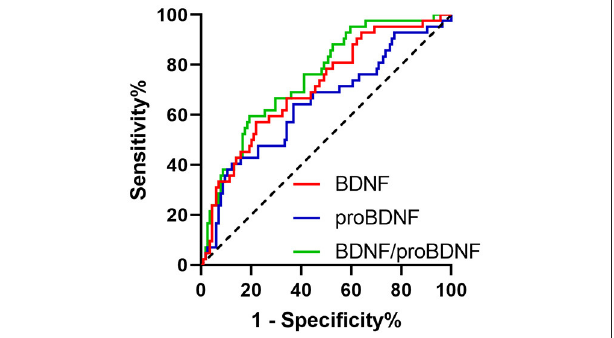
FIGURE 2 | ROC curves of proBDNF, mBDNF, and mBDNF/proBDNF in the follow-up diagnosis of PD.